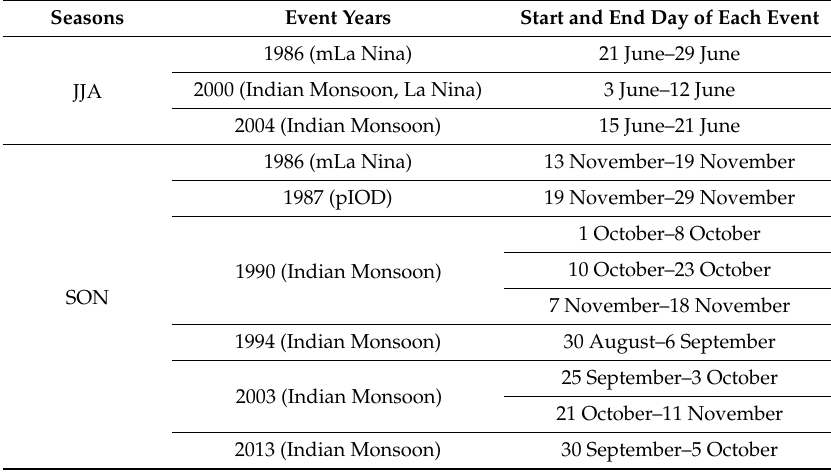
Table 3. The extreme high streamflow events at Rajim station for JJA and SON seasons, where each event is selected from the persistence occurrence of high flows for 6 days or more